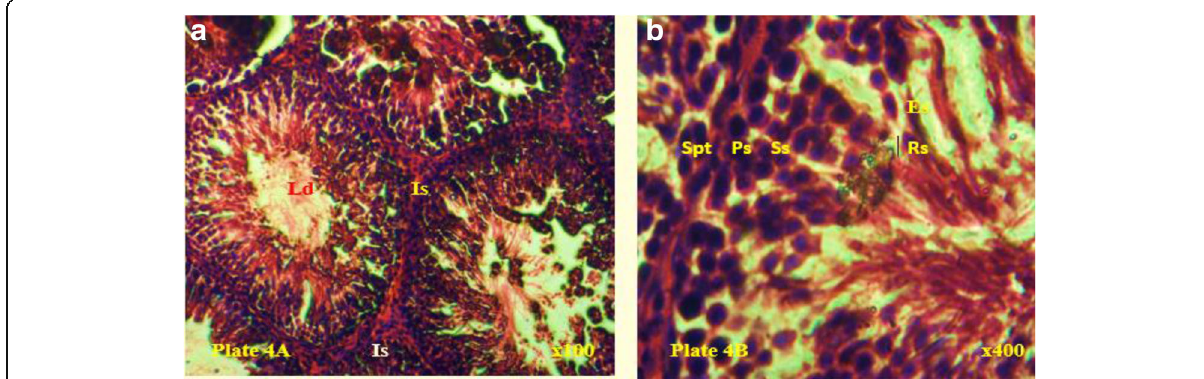
Fig. 8 a , b Photomicrograph of testes of group 2: Representative testicular micrograph of Wistar rats given 100mg/kg/d of aluminum chloride and 1.5ml of pineapple juice (PJ) showing the structure of seminiferous tubules Spt Spermatogonia, Ps Primary Spermatocyte, Ld Luminal diameter, Lc Leydig cell, Rs Round spermatid, Es elongated spermatids, It Interstitial space Stain is H&E and Magnification x 100 and x